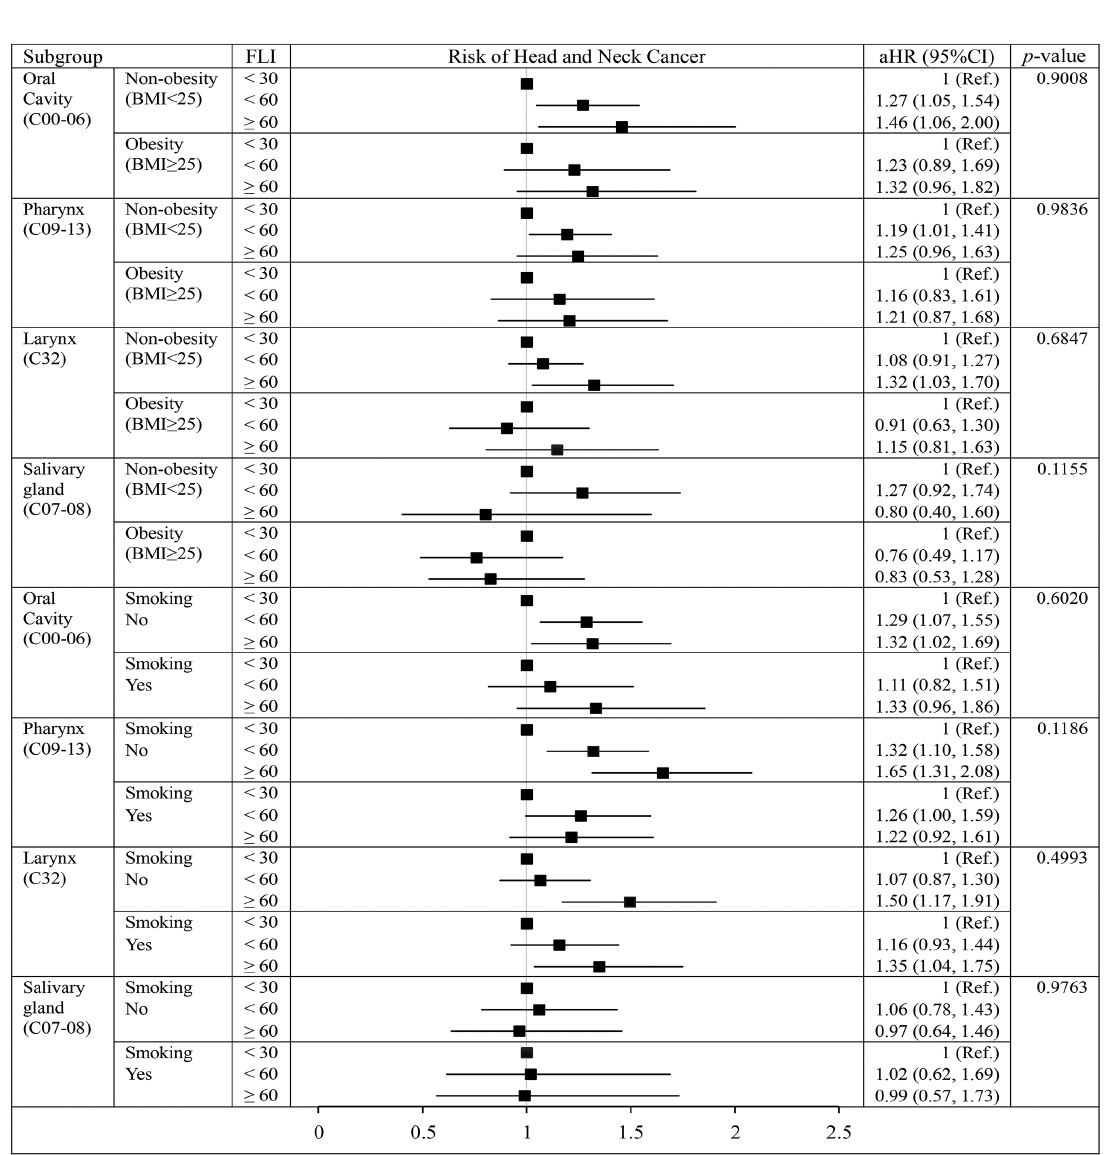
Figure 1. Forest plot of adjusted hazard ratios of head and neck cancer according to obesity and current smoking. BMI, body mass index; aHR, adjusted hazard ratio; CI, confidence interval. Values are adjusted for age, sex, BMI, smoking, alcohol consumption, regular physical activity, income, glucose, insulin, oral hypoglycemic agent, and diabetes mellitus duration.